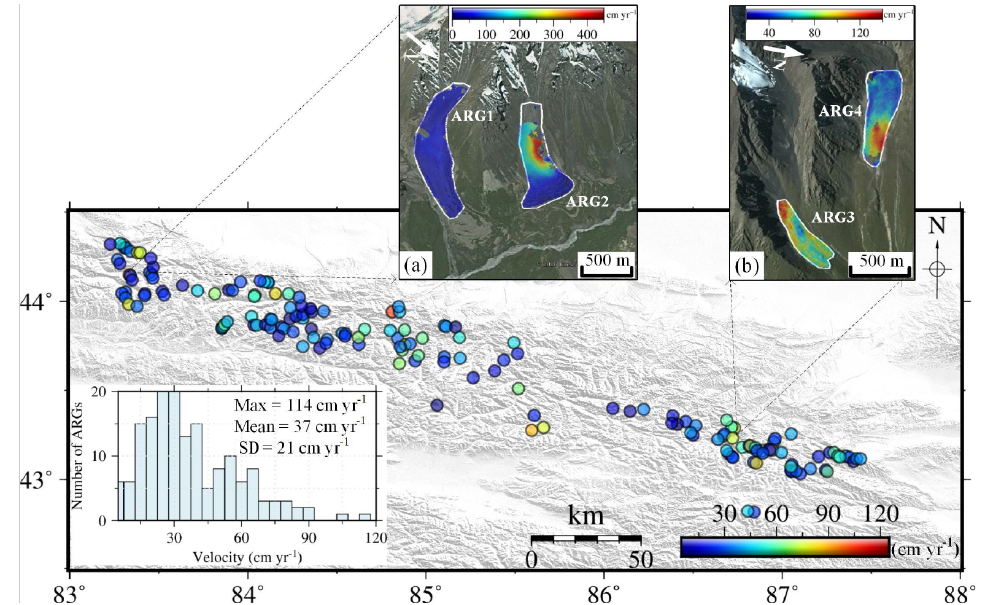
Figure 8. The bottom map shows the downslope velocities of 170 ARGs measured from SAR interferometry, with the histogram shown in the inset. The top two figures show the downslope velocities of two pairs of ARGs adjacent to each other. Note that different velocity color bars are